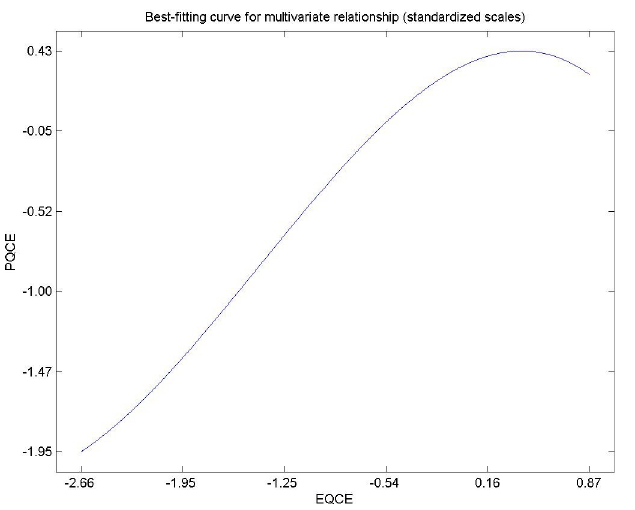
Fig 5. Hypothesis 3,